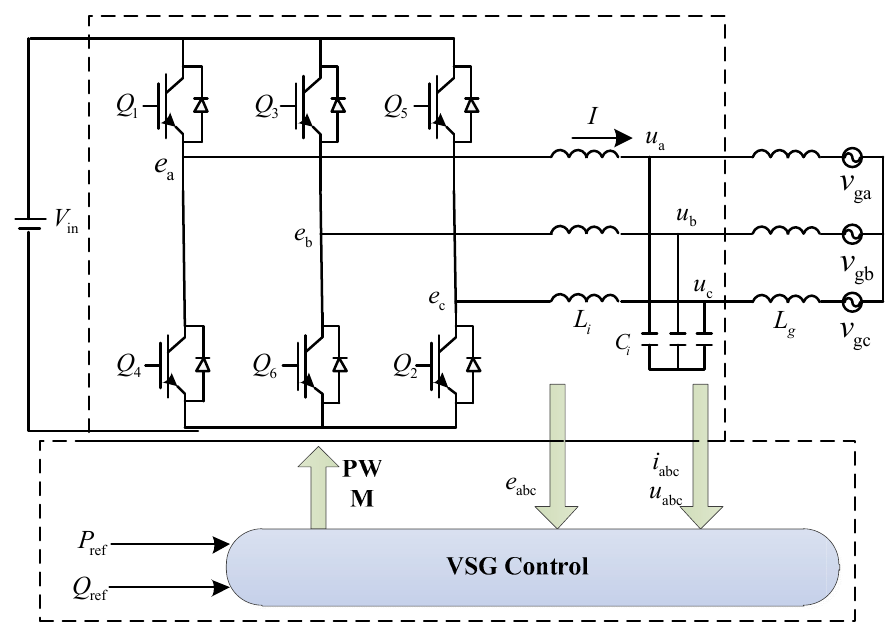
Figure A1. VSG structure in this paper.